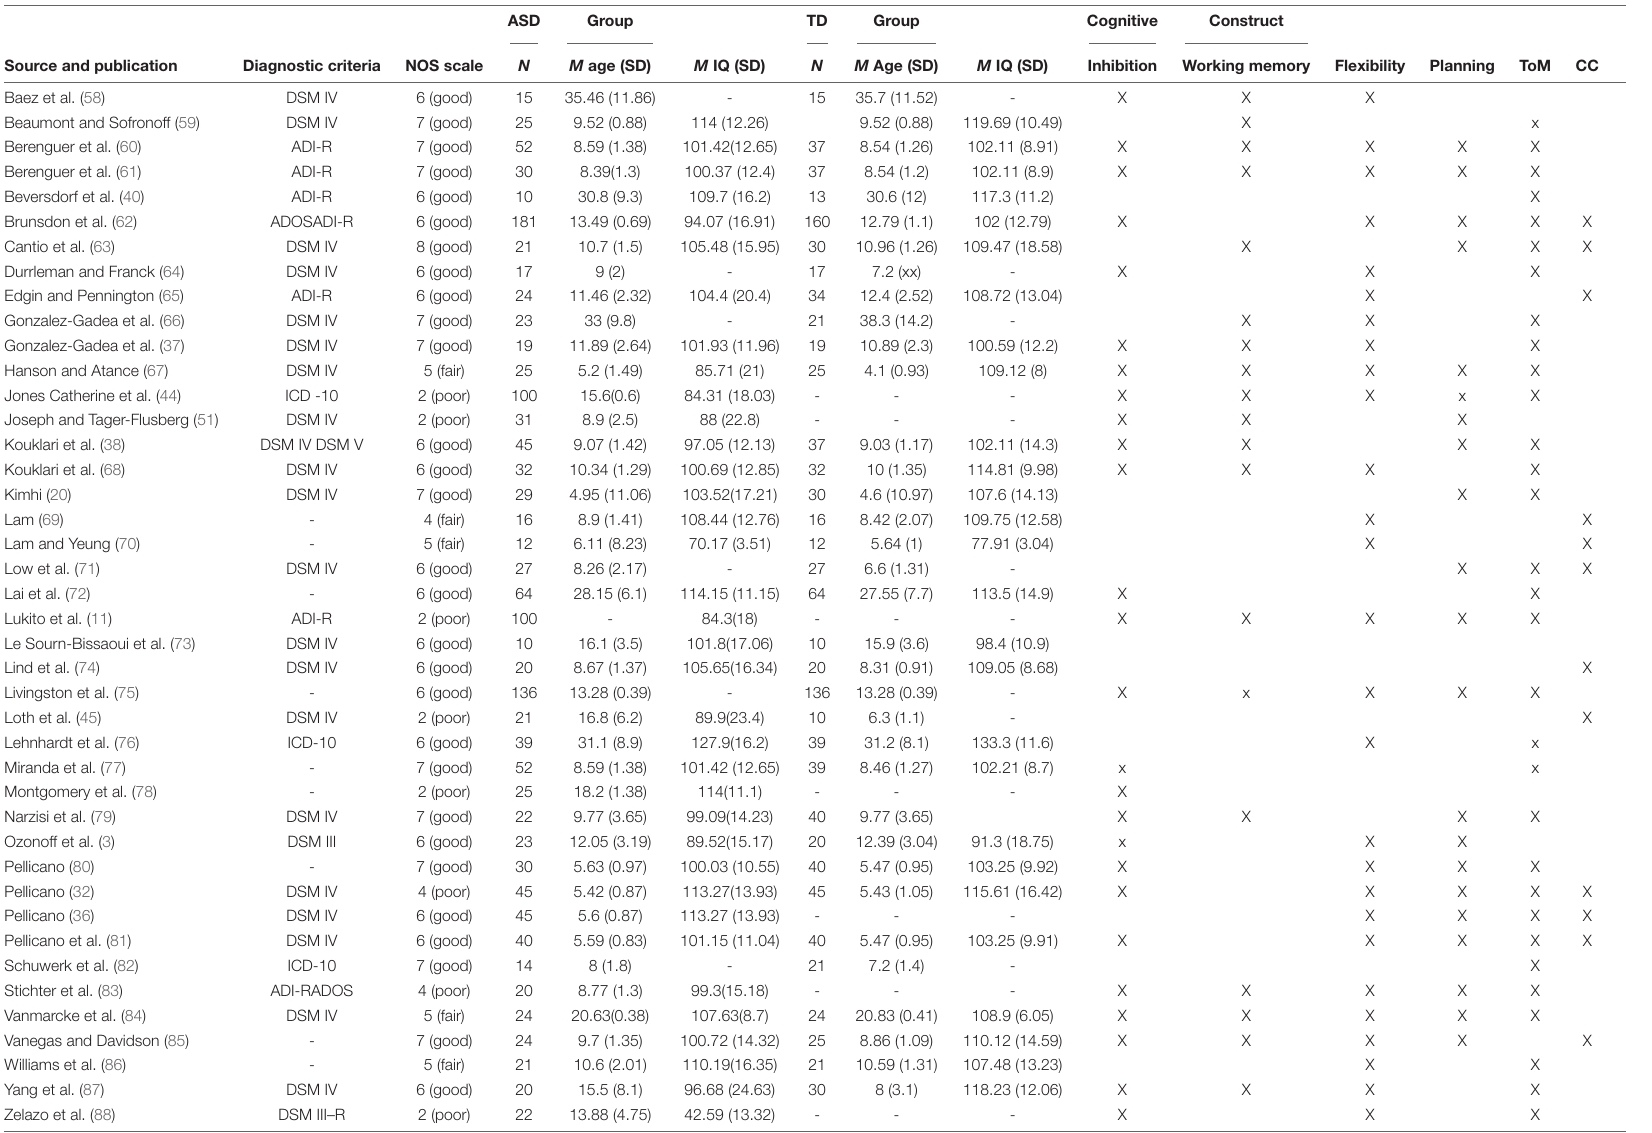
TABLE 2 | Included